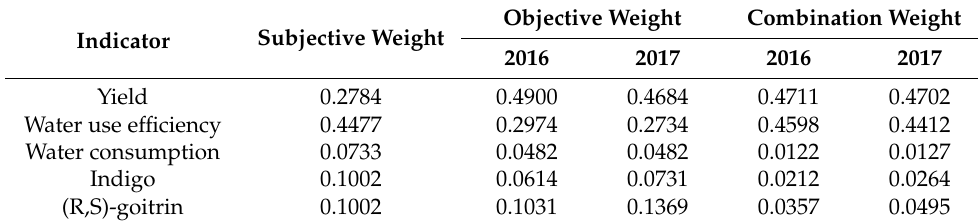
Table 7. The weight of each indicator in the evaluation